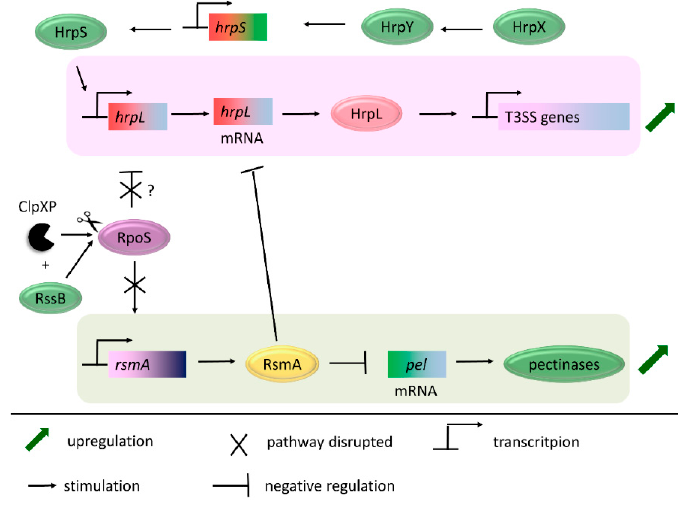
Figure 6. ClpXP positively regulates the expression of virulence associated genes in D. dadantii . ClpXP, with the assistance of the adaptor protein RssB, degrades RpoS (sigma S), an alternative sigma factor and global regulator of transcription. RpoS negatively regulates the activity of the hrpL promoter (by unknown mechanism), resulting in lower levels of hypersensitive response and pathogenicity (Hrp)-L, which is also an alternative sigma factor and is required for the transcription of the T3SS genes. RpoS stimulates the expression of rsmA , whose product destabilizes mRNA molecules, including hrpL mRNA and pectinase mRNA. In the absence of RpoS, the synthesis of T3SS and pectinases is stimulated. Figure based on the literature [179].